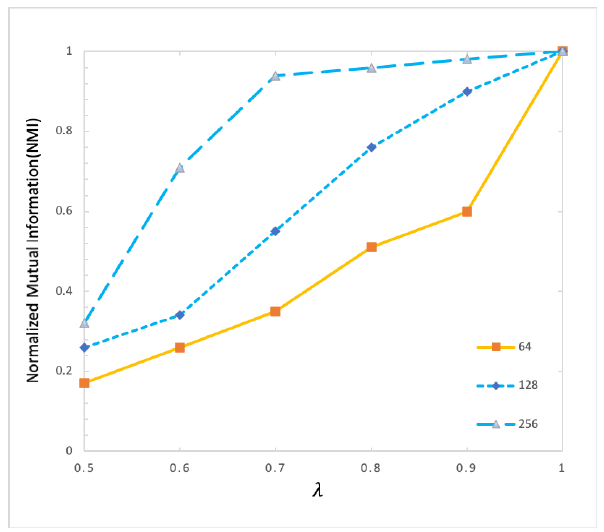
Figure 7. Density Sub-community Node-pair Extraction (DSNE) algorithm uses NMI to evaluate experimental results under different N